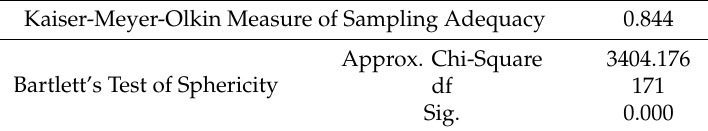
Table 3. Kaiiser–Meyer–Olkin (KMO) and Bartlett’s